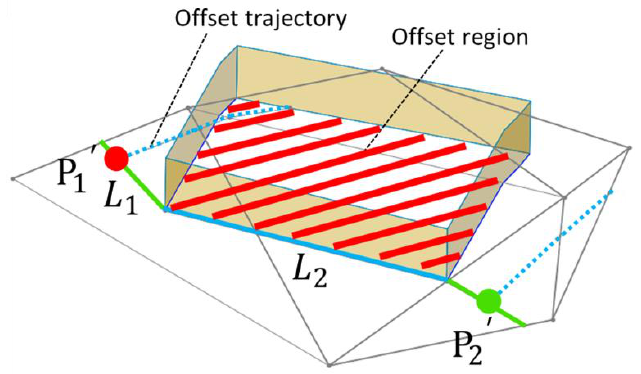
Figure 9. Intersection judgment between the offset region and the offset trajectories of the other discrete points.